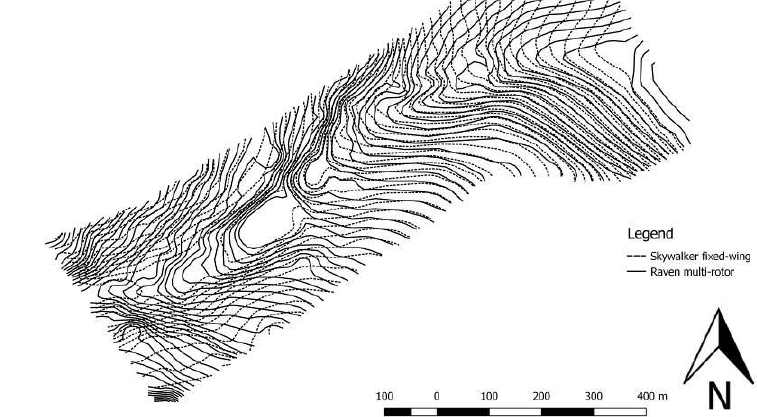
Figure 14. Contour lines derived from the fixed-wing and multi-rotor